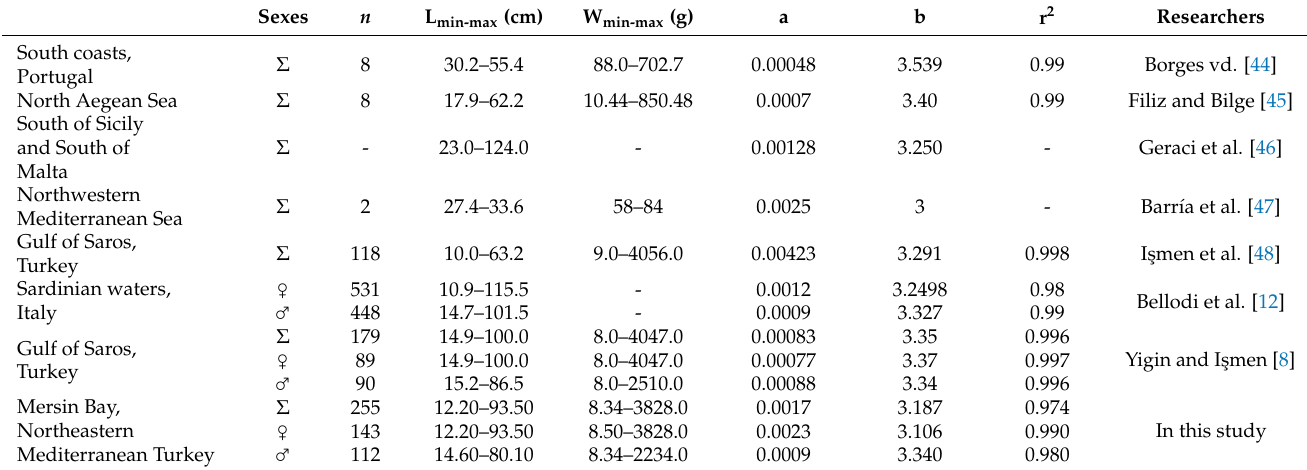
Table 6. Length–weight relationship values for Dipturus oxyrinchus from different